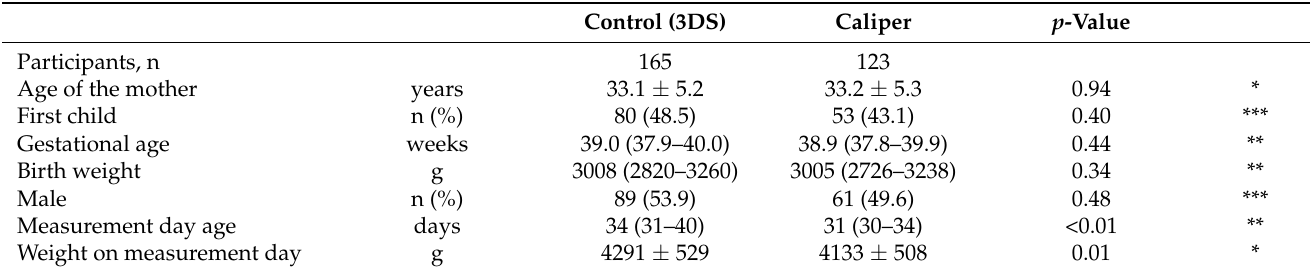
Table 4. Comparison of participant characteristics.